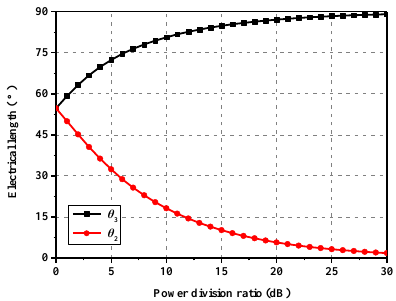
Figure 3. Electrical length versus power division ratio (PDR).